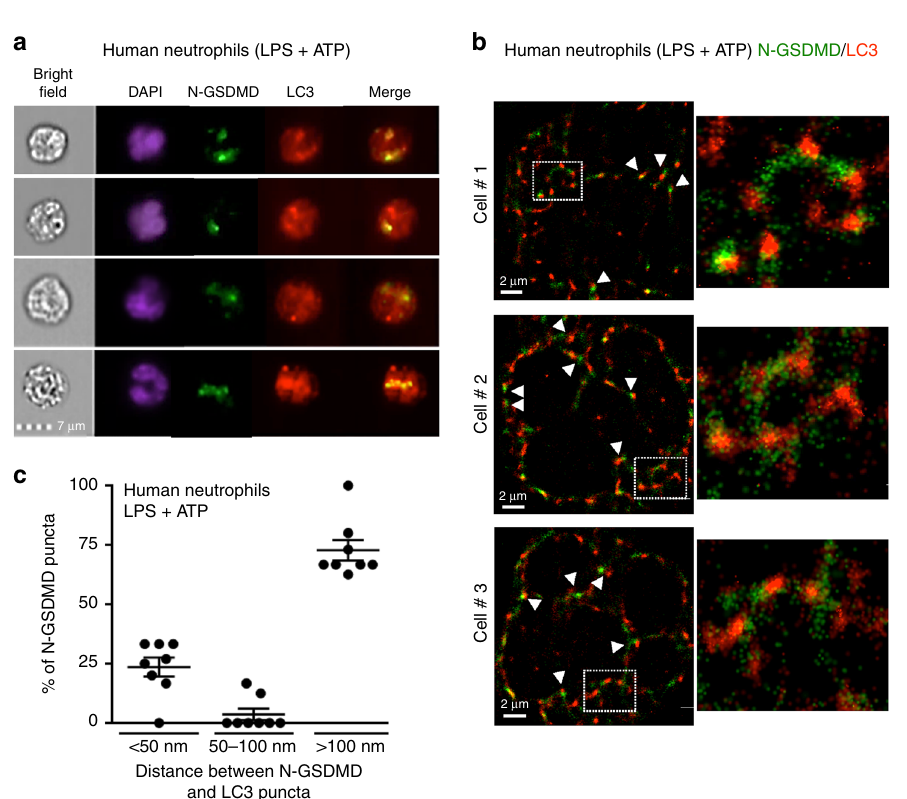
Fig. 5 Localization of neutrophil N-GSDMD to LC3 + autophagosomes. a, b LPS + ATP activated human peripheral blood neutrophils immunostained with antibodies to N-GSDMD (green) and LC3 (red). Representative images were acquired by Imagestream showing overlapping N-GSDMD and LC3 staining ( a ) and by super resolution STORM images ( b ) showing close proximity (indicated by arrowheads) of N-GSDMD (green) and LC3 (red). Enlarged images of boxed areas are shown in the panels on the right. Scale bar = 2 µ m. c Quanti fi cation of N-GSDMD puncta proximity to LC3 puncta. Each data point represents one neutrophil (median of 8 foci measured per cell), and percent of puncta where N-GSDMD is <50 nm, 50 – 100 nm, or >100 nm from LC3. Imagestream data are representative of at least 3 independent experiments from human blood donors ( n = 3). Source data for panel C is provided in the separate Source Data fi